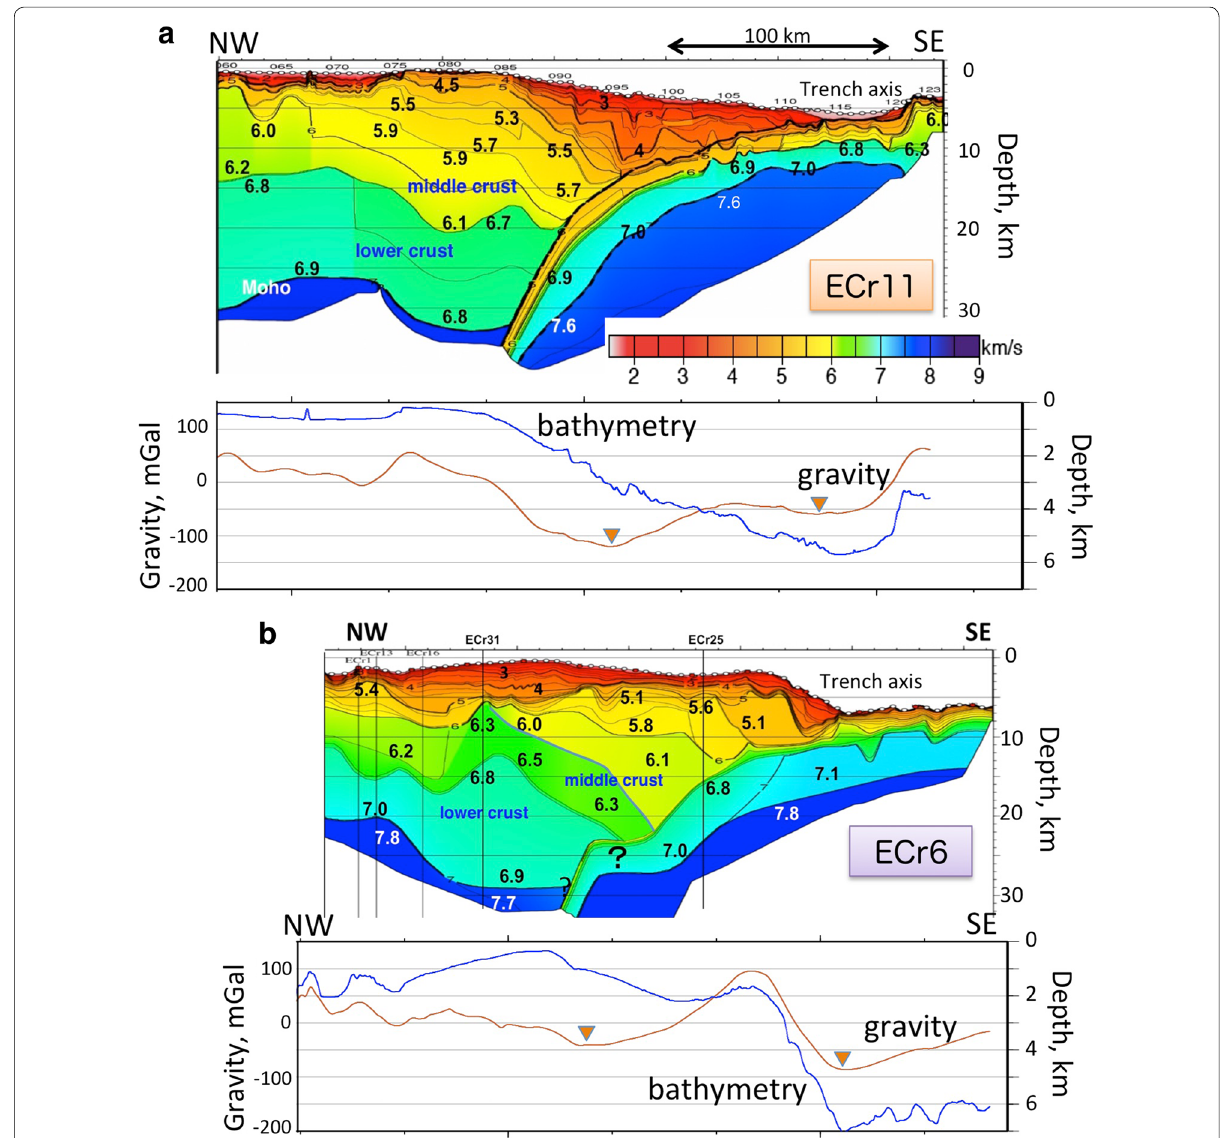
Fig. 9 V p model and free-air gravity anomaly. Two low gravity peaks are shown by triangles on each gravity profile. a ECr11 and b